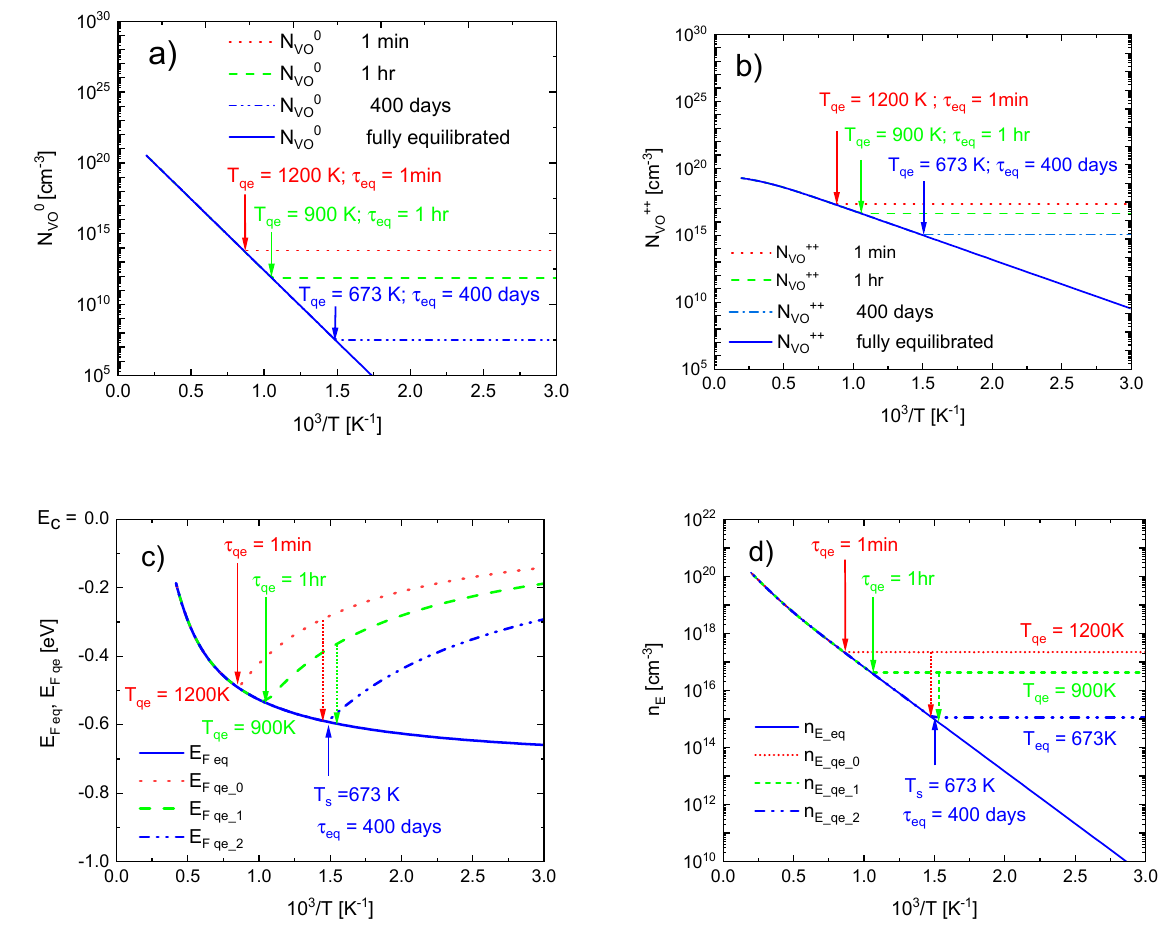
Figure 6. ( a , b ): Effect of increasingly longer equilibration times τ eq on the quenched-in (qe) concen- trations of neutral ( a ) and two-fold positively charged ( b ) oxygen vacancy densities. Quenched-in concentrations relate to increasingly lower quench-in temperatures T qe ; ( c , d ): Effect of thermal quenching on temperature-dependent Fermi energy positions ( c ) and quenched-in excess carrier densities ( d ). Dash-dotted vertical lines indicate slow subsequent relaxation towards sensor operation temperature specific values of Fermi energy position and equilibrated mobile carrier densities.